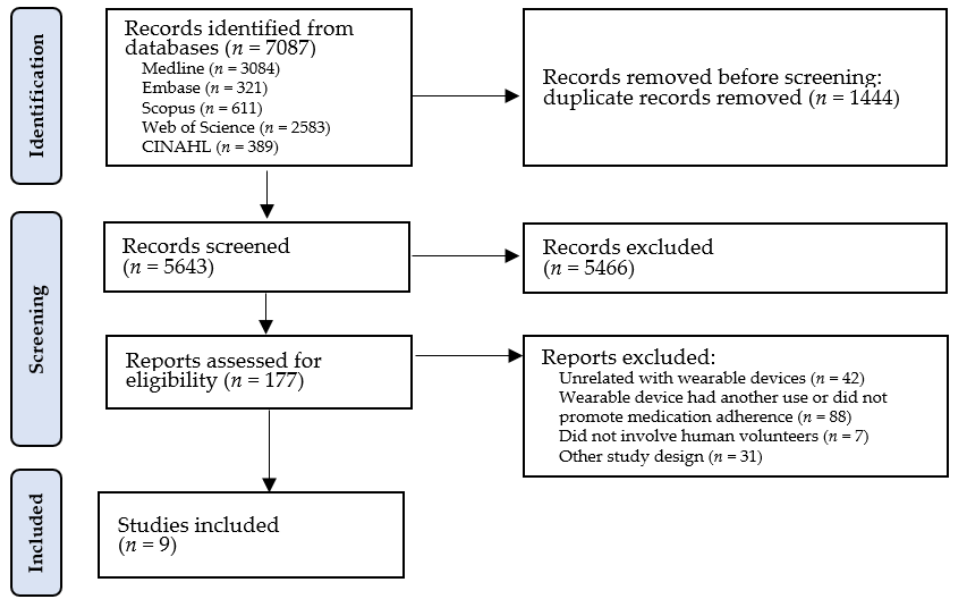
Figure 1. Flow diagram of study selection process based on PRISMA.